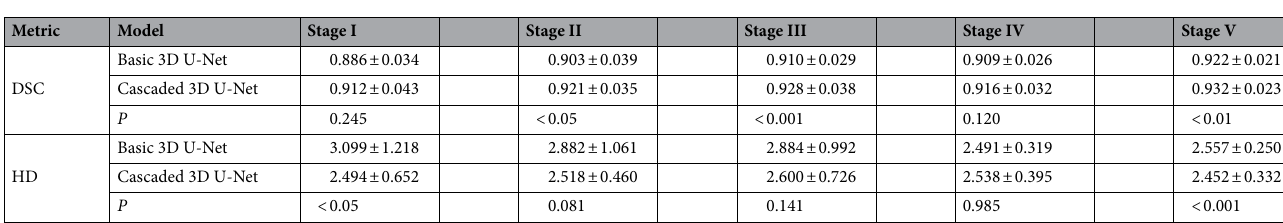
Table 3. Dice similarity coefficient and Hausdorff distance for each stage with 3D U-Net only and cascaded 3D U-Net (DSC, Dice similarity coefficient; HD, Hausdorff